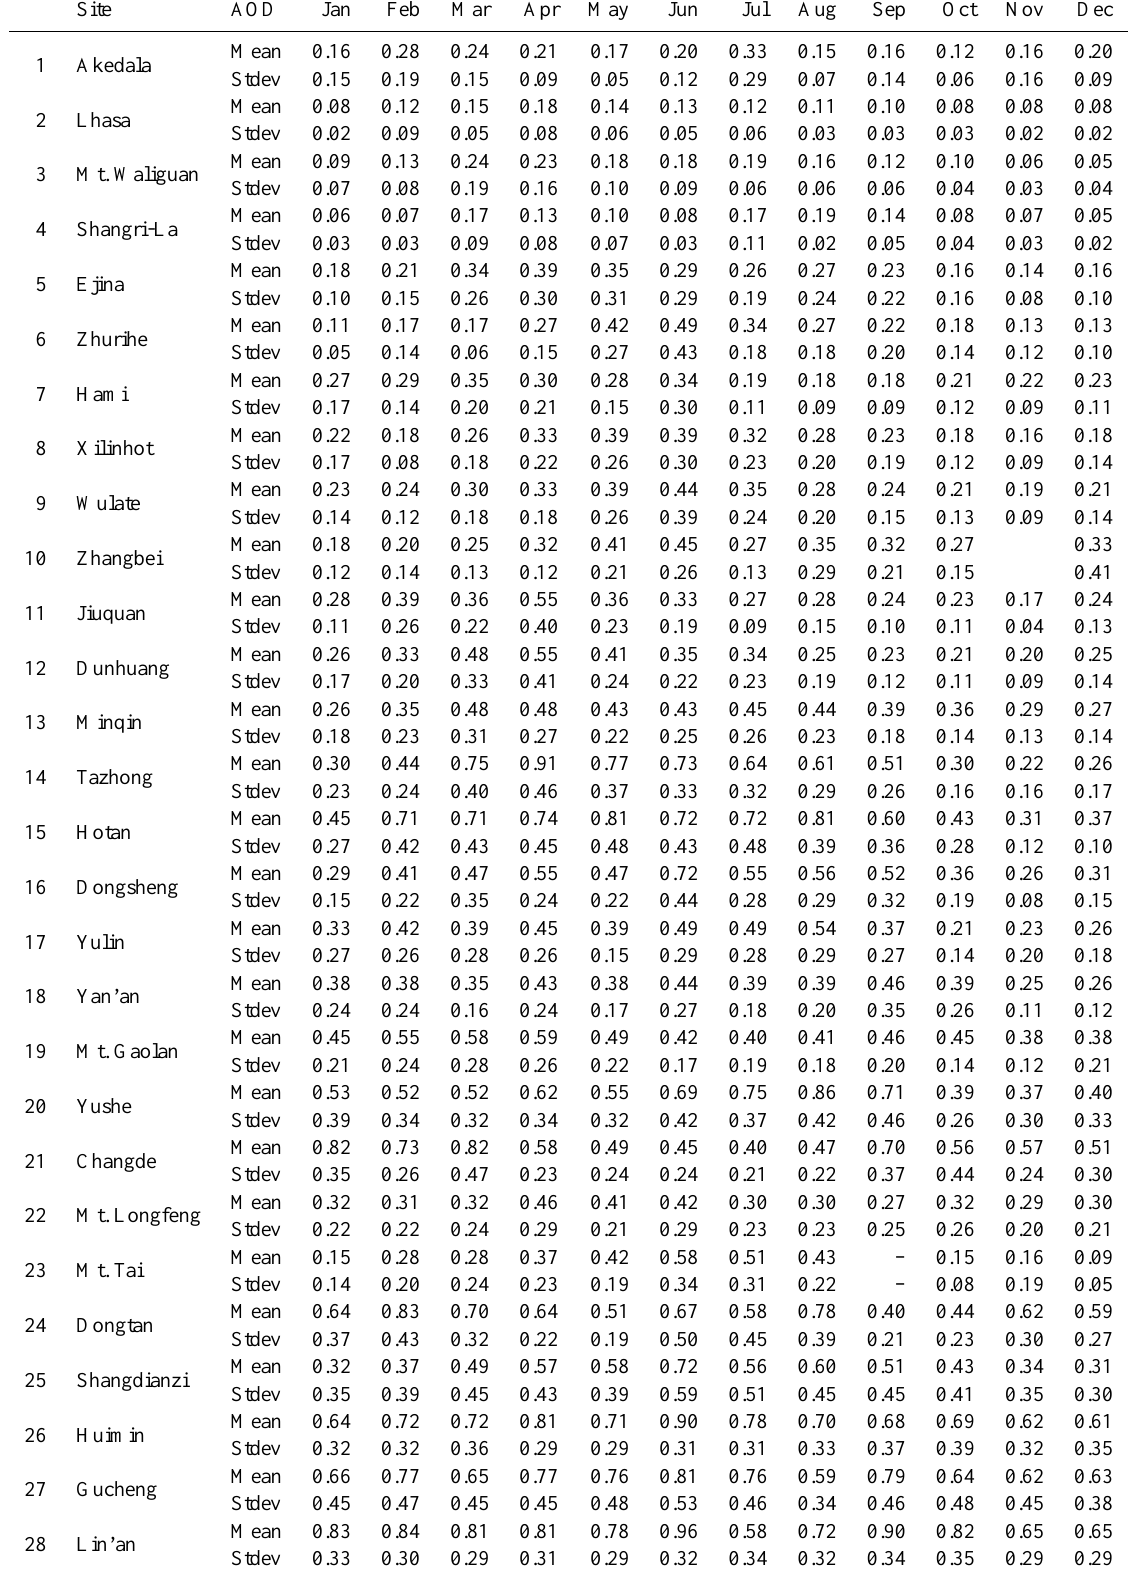
Table A3. Data of Figs. 6–15: AOD at